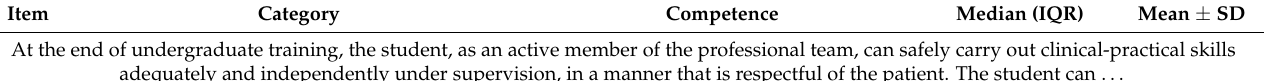
Table 4. Overview of all items asked in the individual categories in the field of emergency medicine and the average rating of the participants from 1 (“not relevant at all”) to 6 (“very relevant”) as median and IQR and mean value and